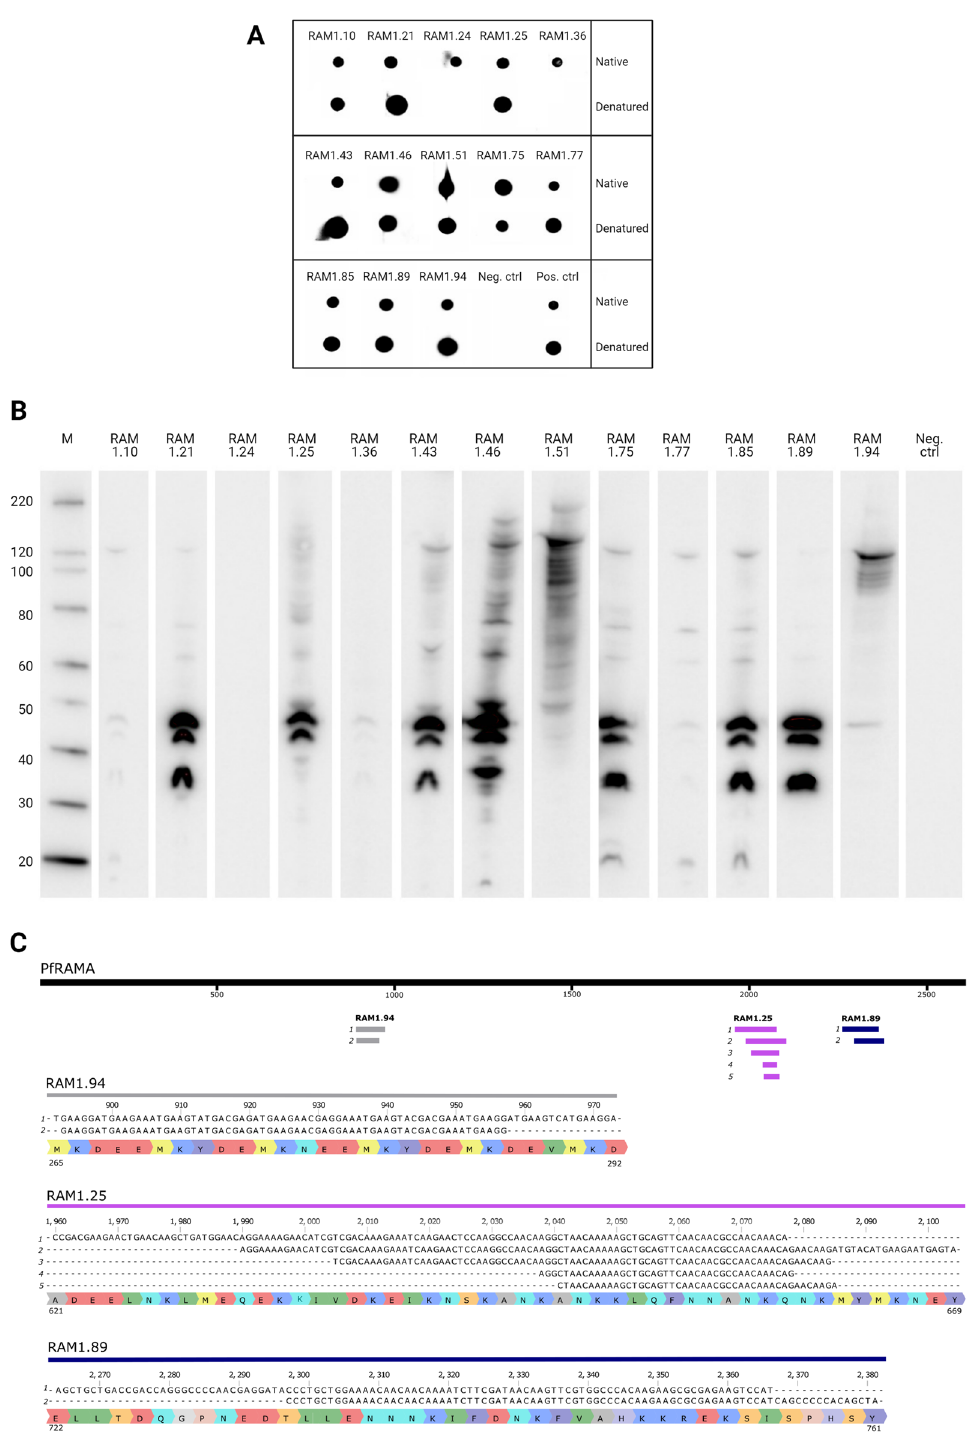
Figure 5. Assessing the binding domain of anti-PfRAMA mAbs. (A) Dot blot showing anti-PfRAMA mAbs binding to recombinant PfRAMA in native or denatured conditions. The negative control is the secondary anti-mouse IgG—HRP only, while the positive control is an anti-his(C-term)—HRP antibody. Unprocessed images of dot blots can be found in supplementary information Fig. S2 (B) Western blot on lysates from a synchronized culture of schizont-infected erythrocytes, roughly 40 h post-infection. The western blot was probed with anti-PfRAMA mAbs, which were detected by a rabbit anti-mouse immunoglobulin—HRP conjugated antibody. Molecular weight marker (MagicMark) is shown on the left and the negative control (detection antibody only) on schizont lysates, is shown on the right. Unprocessed images of western blots can be found in supplementary information Fig. S3. (C) Gene fragments identified with mAbs RAM1.25, RAM1.89 and RAM1.94 aligned to PfRAMA. The PfRAMA gene is shown in black with numbered base pairs as an overview. The sequences of the gene fragments derived from panning with mAbs RAM1.94 (grey), RAM1.25 (purple), and RAM1.89 (blue) are aligned to the PfRAMA gene, displayed as colored lines. Below, a detailed sketch provides the exact sequences and the encoded amino acids. Two unique gene fragments were identified with RAM1.94, five with RAM1.25 and another two with RAM1.89. The gene fragments are numbered according to the clone number shown in Supplementary Fig.